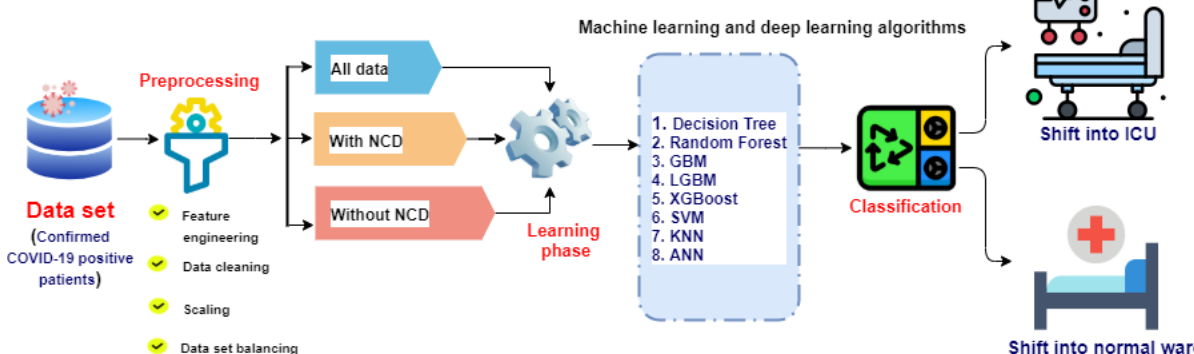
Figure 1. Proposed methodology and workflow of the machine learning analysis in this study. ANN: artificial neural network; GBM: gradient boosting machine; ICU: intensive care unit; LGBM: light gradient boosting machine; NCD: noncommunicable disease; SVM: support vector machine; KNN: k-nearest neighbor; XGBoost: extreme gradient